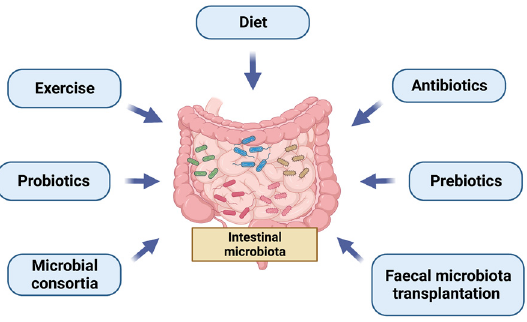
Figure 1. Different ways to manipulate gut Figure 1. Di ff erent ways to manipulate gut microbiota.